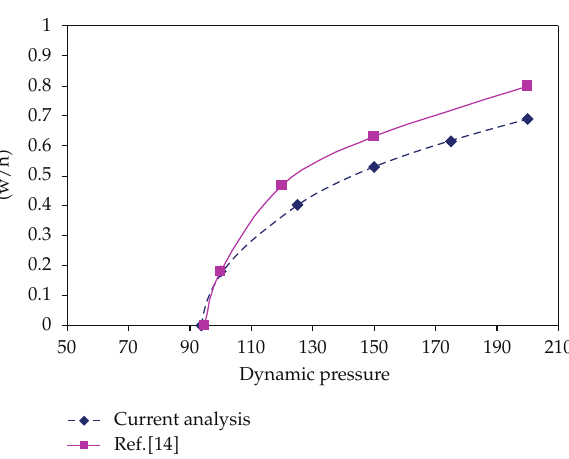
Figure 5: Amplitude of limit-cycle oscillations versus dimensionless dynamic pressure for a cantilevered square plate in dimensionless coordinates (cid:3) x/a,y/b (cid:6) (cid:9) (cid:3) 1 , 0 . 75 (cid:6) .